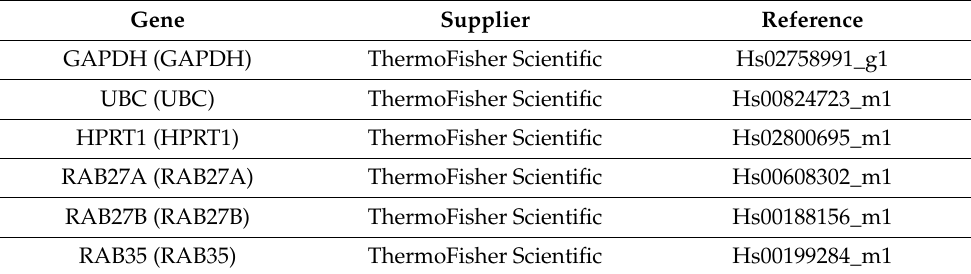
Table 2. References of probes used for quantitative